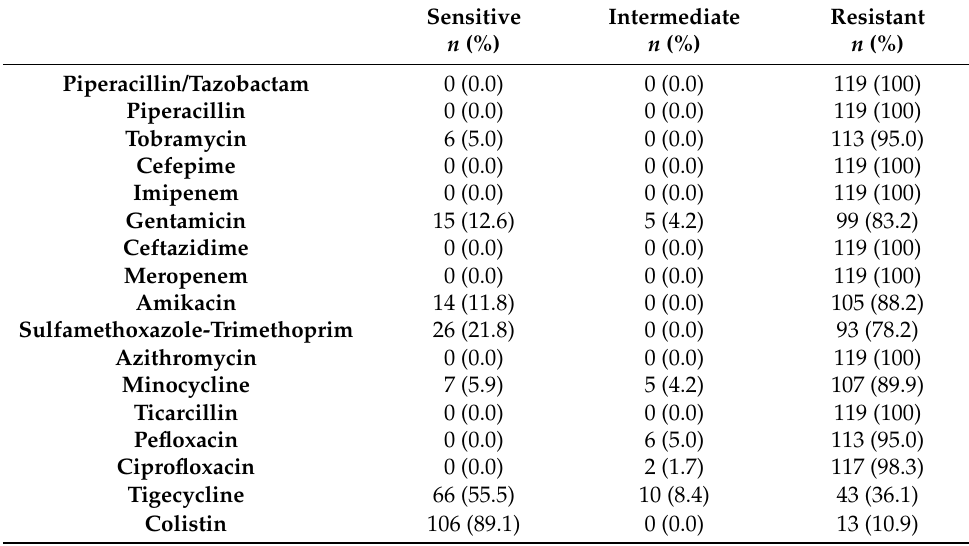
Table 2. Distribution of the studied isolates according to antimicrobial